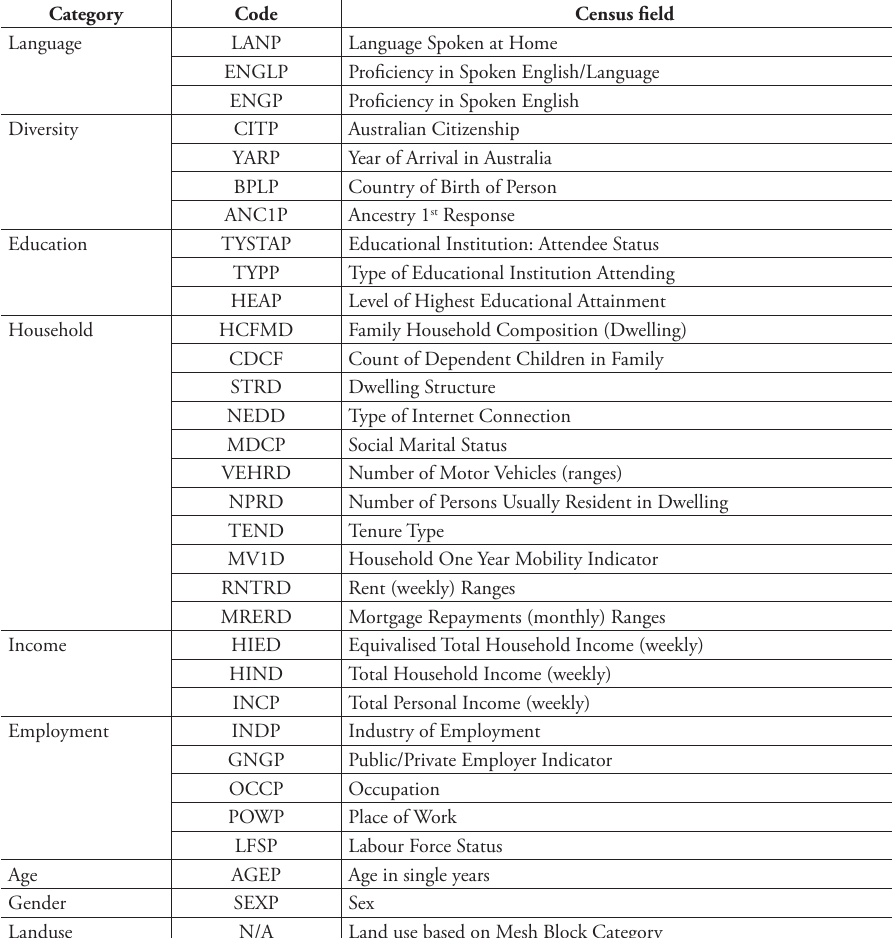
Table 1. Census fields considered in the